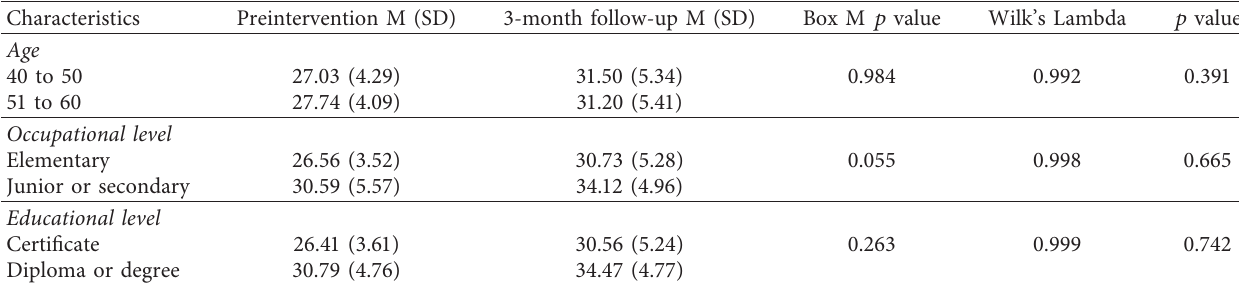
Table 4: Effectiveness of educational intervention on practice across background characteristics.